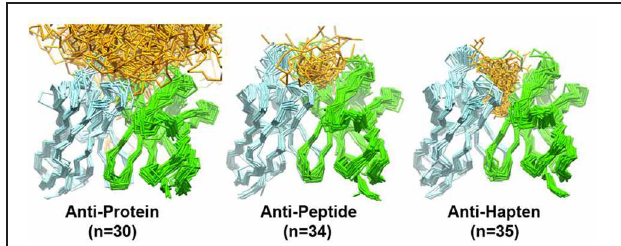
peptides, and 35 with haptens. V H colored in dark blue. V L colored in light blue. Ligands are colored in orange. The coordinates used to generate